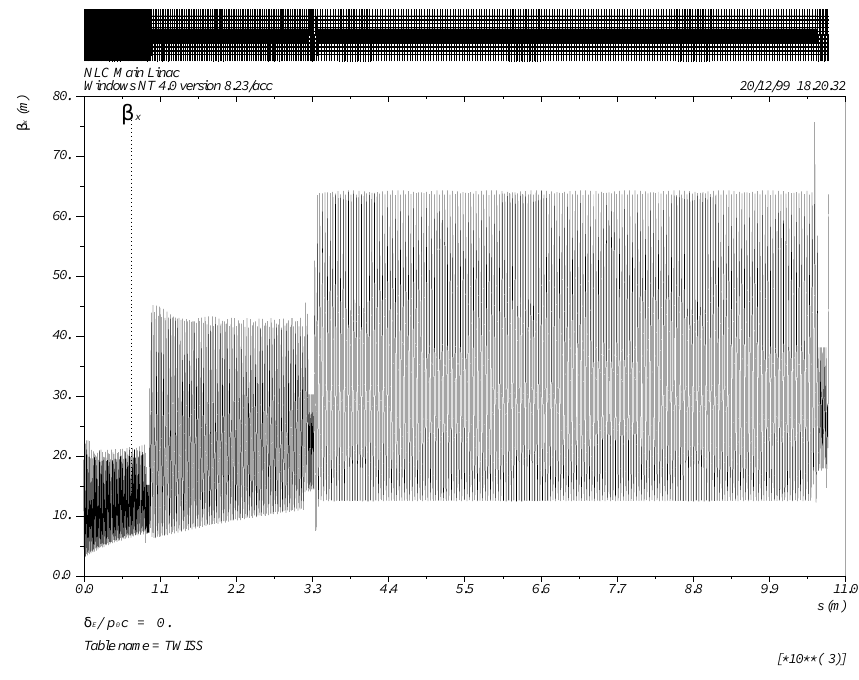
FIG. 2. Horizontal betatron function of the NLC main